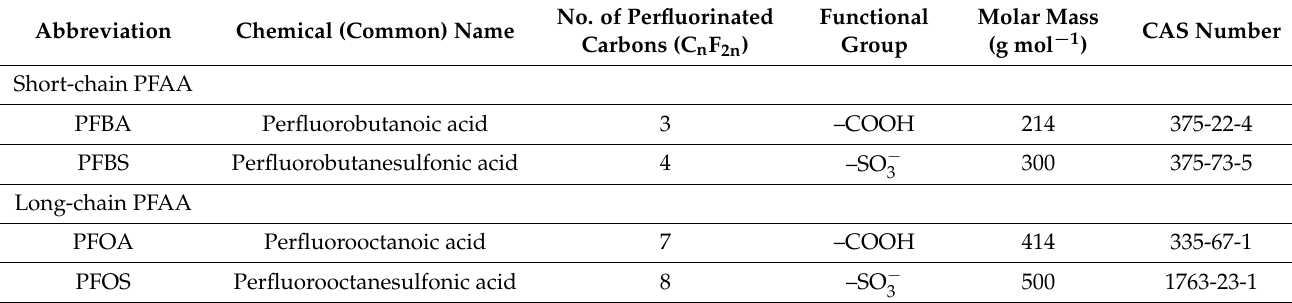
Table 4. List of Considered PFAAs in the Increasing Chain-Length